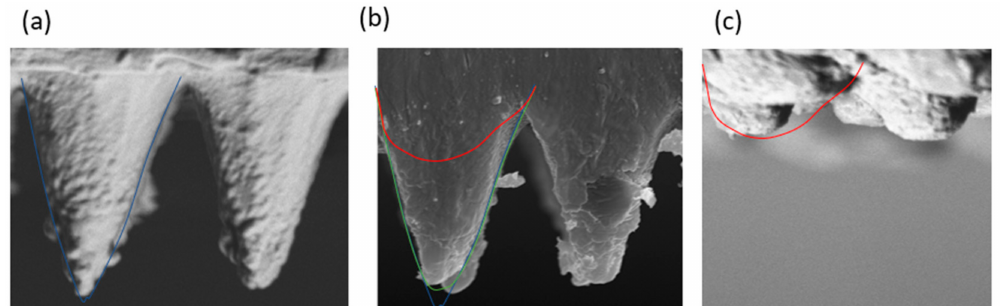
Figure 9. Experimental results of ( a ) best replication in silicone, ( b ) acceptable replication in PP with hot mold, and ( c ) incomplete replication in PP with cold mold.